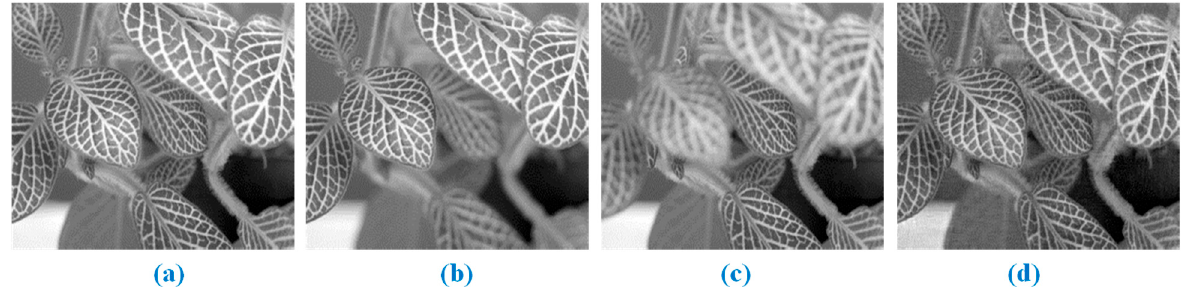
Figure 14. (Leaf): ( a ) original image; ( b , c ) multi-focus input images; and ( d ) proposed fusion. Table 30. The outcomes for the leaf image and comparisons with existing techniques in the literature ([21]).